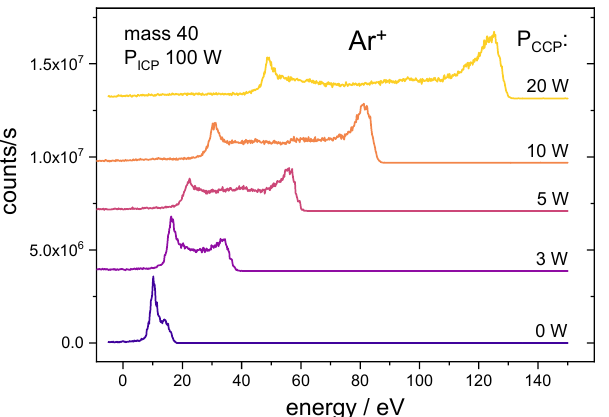
Figure 7. IEDFs of Ar + as function of applied power of the capacitively coupled bias on the reactor wall. Argon pressure 5 Pa.